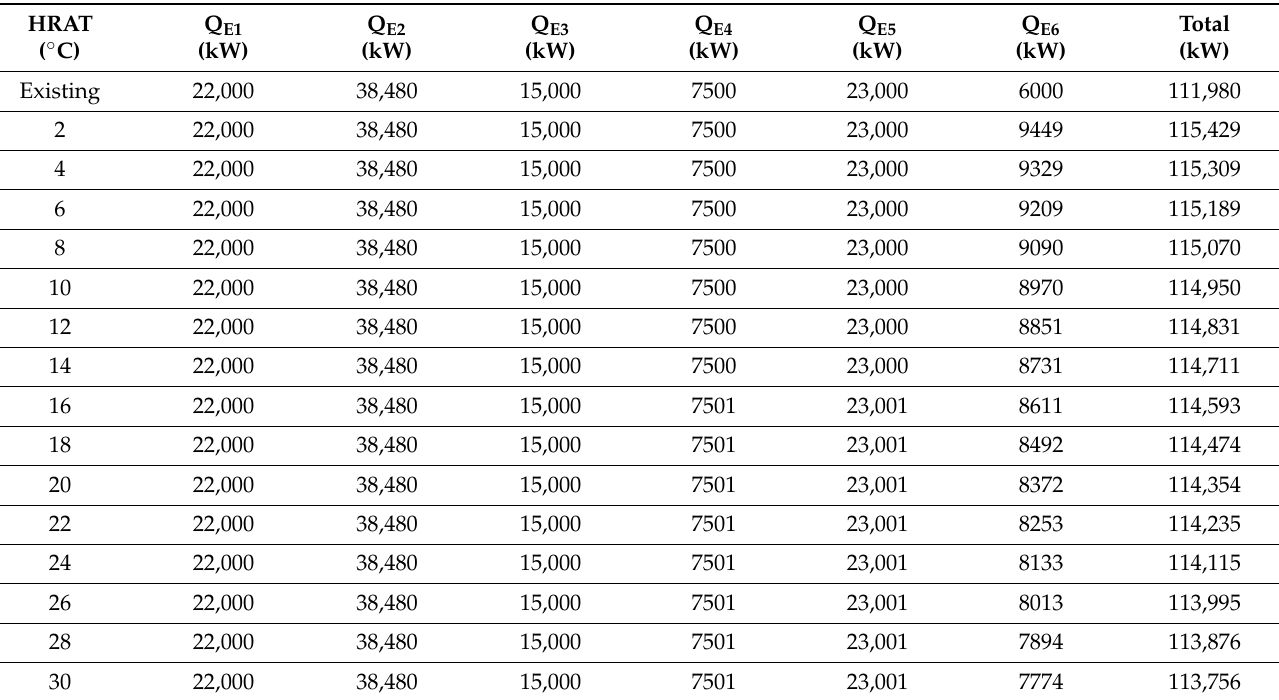
Table A2. Heat loads at different HRAT values for option (2).